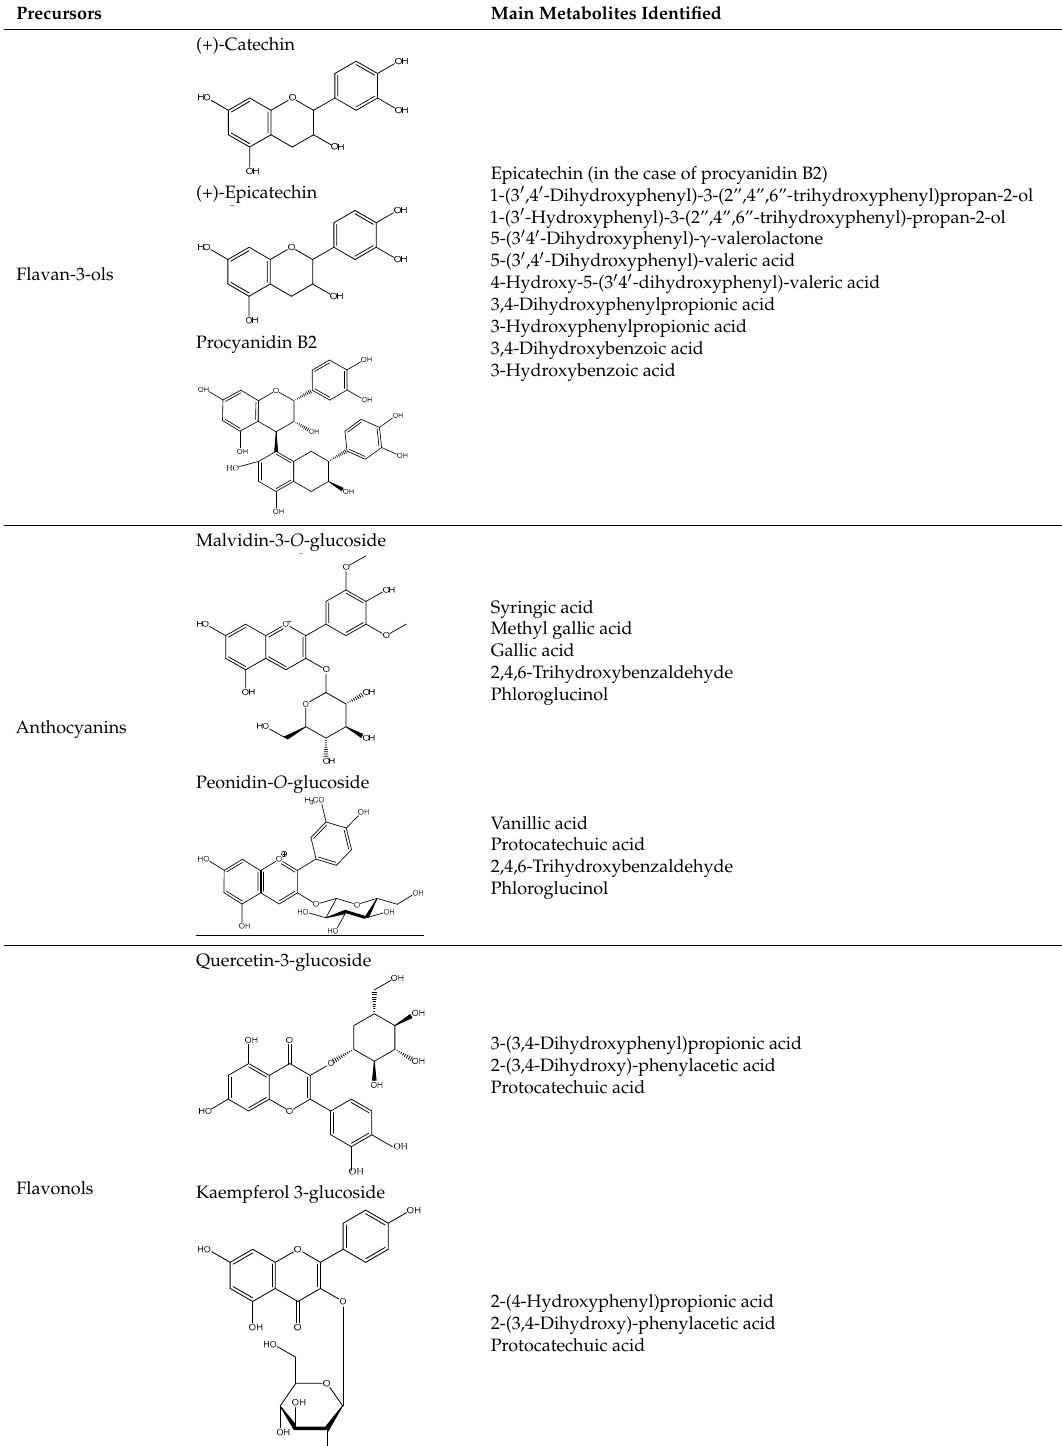
Table 1. Main class of grape and wine polyphenols and their microbial-derived metabolites.